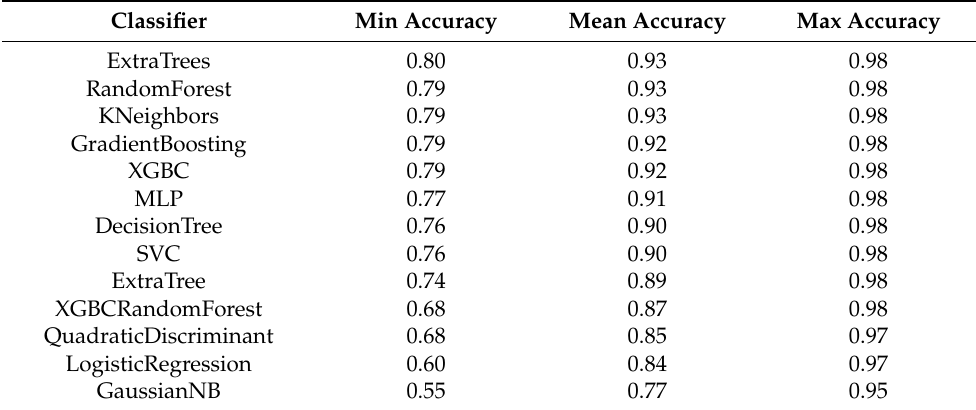
Table 7. Accuracy statistics obtained by the classifiers for the entire time-series in the evalua- tion